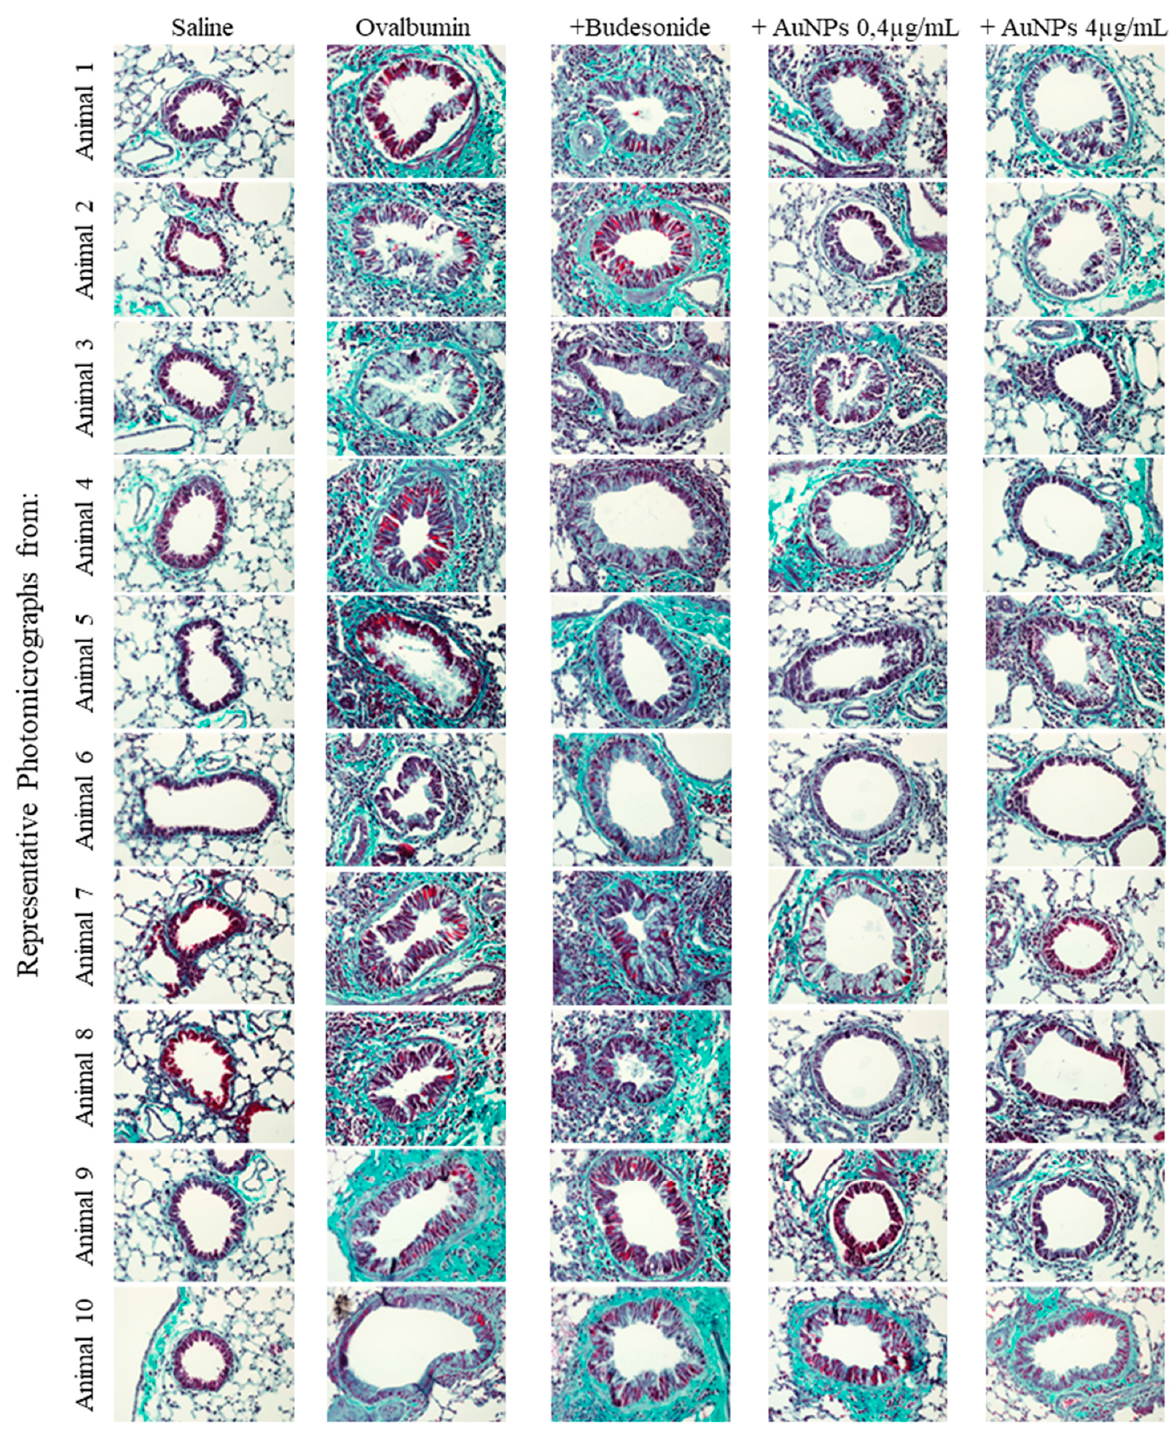
Figure A3. Effect of nebulized budesonide or AuNPs on mucus production and airway remodeling following ovalbumin intranasal instillation given once a week for 9 weeks. Photomicrographs were taken of representative airways (animals 1 to 10) stained by Gömöri trichrome (Extra cellular matrix deposit) from ovalbumin-sensitized mice challenged with saline (Saline), challenged with ovalbumin (Ovalbumin), challenged with ovalbumin and treated with budesonide (+Budesonide), challenged with ovalbumin and treated with AuNPs (+0.4 µ g/mL AuNP) and challenged with ovalbumin and treated with AuNPs (+4 µ g/mL